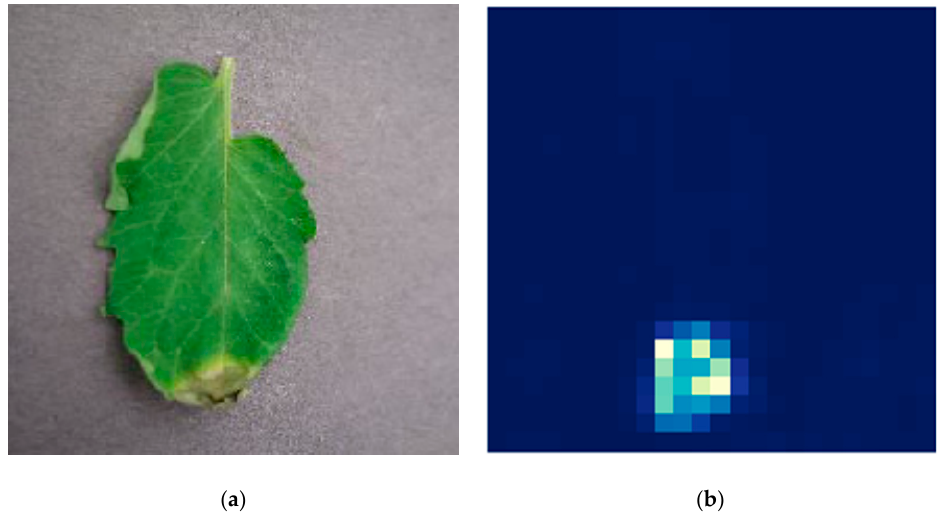
Figure 5. ( a ) Original image, ( b ) occlusion sensitivity of 14-DCNN.